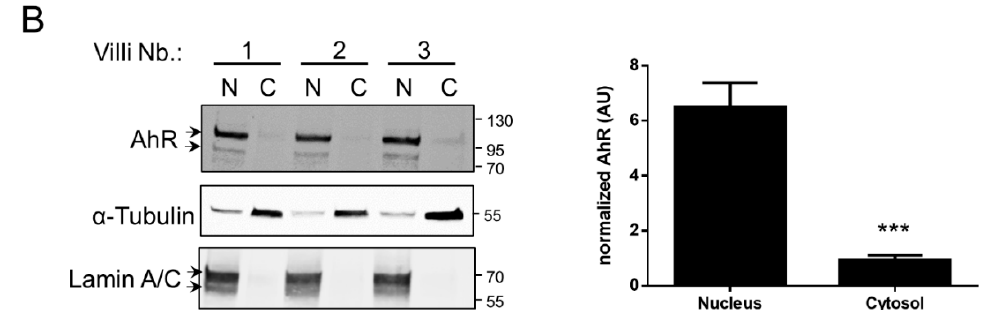
Figure 2. AhR localization in chorionic villi of placenta at different periods of pregnancy. ( A ) Chorionic villi from placentae for different periods of pregnancy (as indicated) were fixed in 4% PFA, included in agarose, and permeabilized with 0.5% Triton. Images are of confocal microscopy after immunostaining with anti-AhR antibody alone (HPA029723) (green, upper images) or anti-AhR pre-incubated with a blocking peptide (lowest image), of anti-cytokeratin 7 antibody (red, to underline the trophoblasts) and DAPI (blue, for nuclei). The overlay images are shown at right. Images are representative of four independent experiments. ( B ) Immunoblotting was carried out using anti-AhR antibody after cell fractionation of freshly harvested term chorionic villi to separate nuclear and cytosolic extracts. α -Tubulin and Lamin A/C are nuclear and cytosolic markers, respectively. N: Nucleus, C: Cytosol. The bar graph represents the total amount of AhR protein (two bands) normalized as following: Nuclear AhR level was normalized by Lamin A/C signal then nuclear contamination by cytosolic fraction ( α -Tubulin/Lamin A/C ratio) was subtracted; cytosolic AhR level was normalized by α -Tubulin level then cytosolic contamination by nuclear fraction (Lamin A/C/ α -Tubulin ratio) was subtracted. Protein levels were determined by quantification of immunoblot analysis using the Odyssey System Imager. The means (long horizontal lines) and standard deviations (short horizontal lines) of three distinct villi are shown (*** p < 0.001).